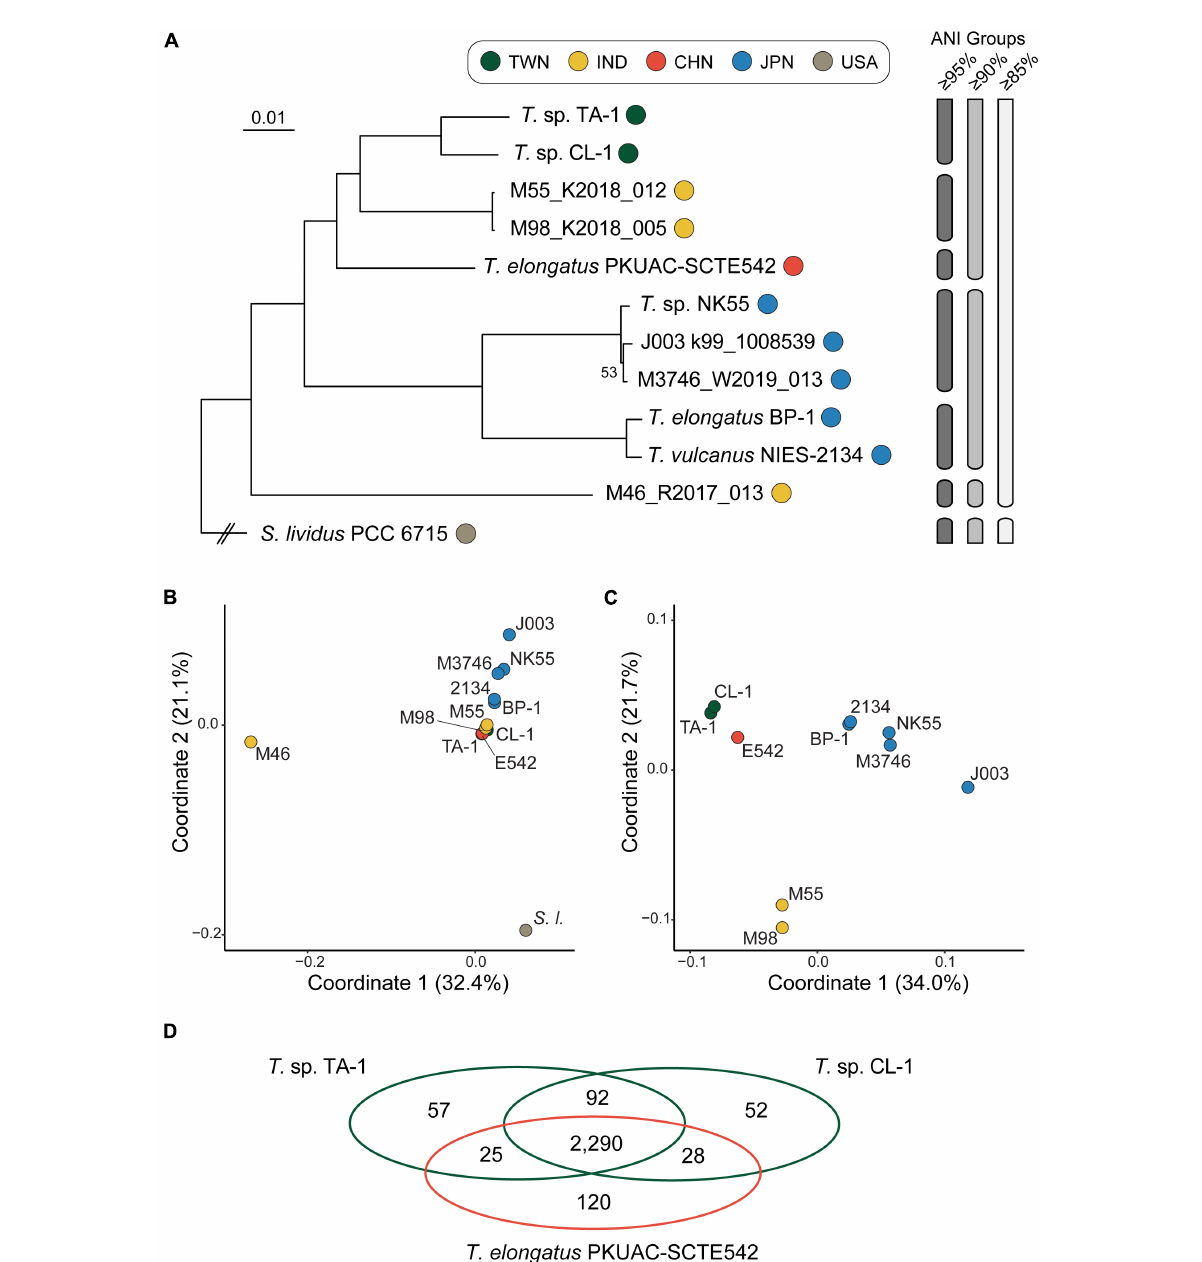
FIGURE1 Relationships among representative Thermosynechococcus strains. The strains are color-coded according to the geographic origin. TWN, Taiwan; IND, India; CHN, China; JPN, Japan; USA, United States of America. The metagenome-assembled genomes are identified by only the strain names but not the scientific names. (A) Maximum-likelihood phylogeny based on 1,311 single-copy genes conserved among all genome sequences analyzed. The concatenated alignment of 383,962 aligned amino acid sites. The bootstrap support was inferred based on 1,000 replicates, the only one internal branch that received < 100% support was labeled. The grouping of strains based on different thresholds of average nucleotide identity (ANI) is illustrated on the right. (B) Gene content dissimilarity among all strains based on principal coordinate analysis. (C) Gene content dissimilarity, excluding the outgroup and a highly divergent strain M46_R2017_013 to improve the resolution. (D) A Venn diagram illustrates the numbers of shared and unique homologous gene clusters among three focal